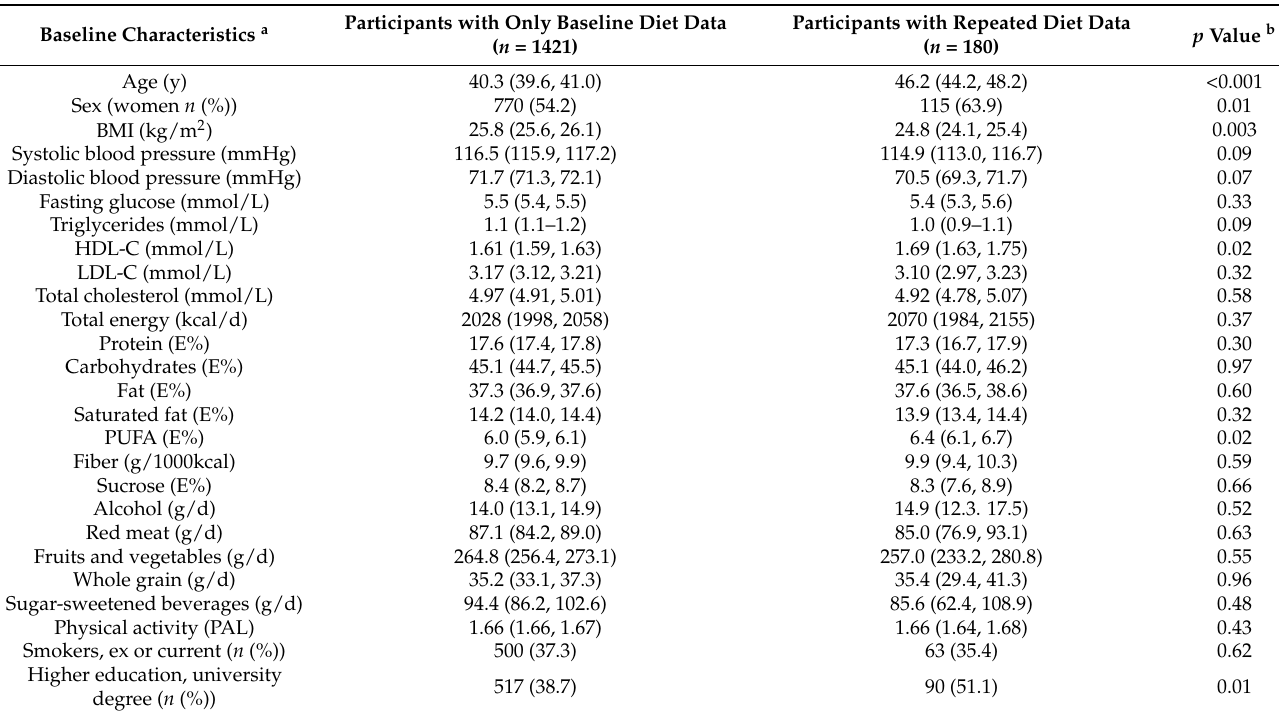
Table 1. Baseline characteristics among the 1601 MOS participants with single ( n = 1421) or repeated dietary data from both 4-d food records (4DFR) and the short food frequency questionnaire (SFFQ) ( n = 180). Baseline Characteristics